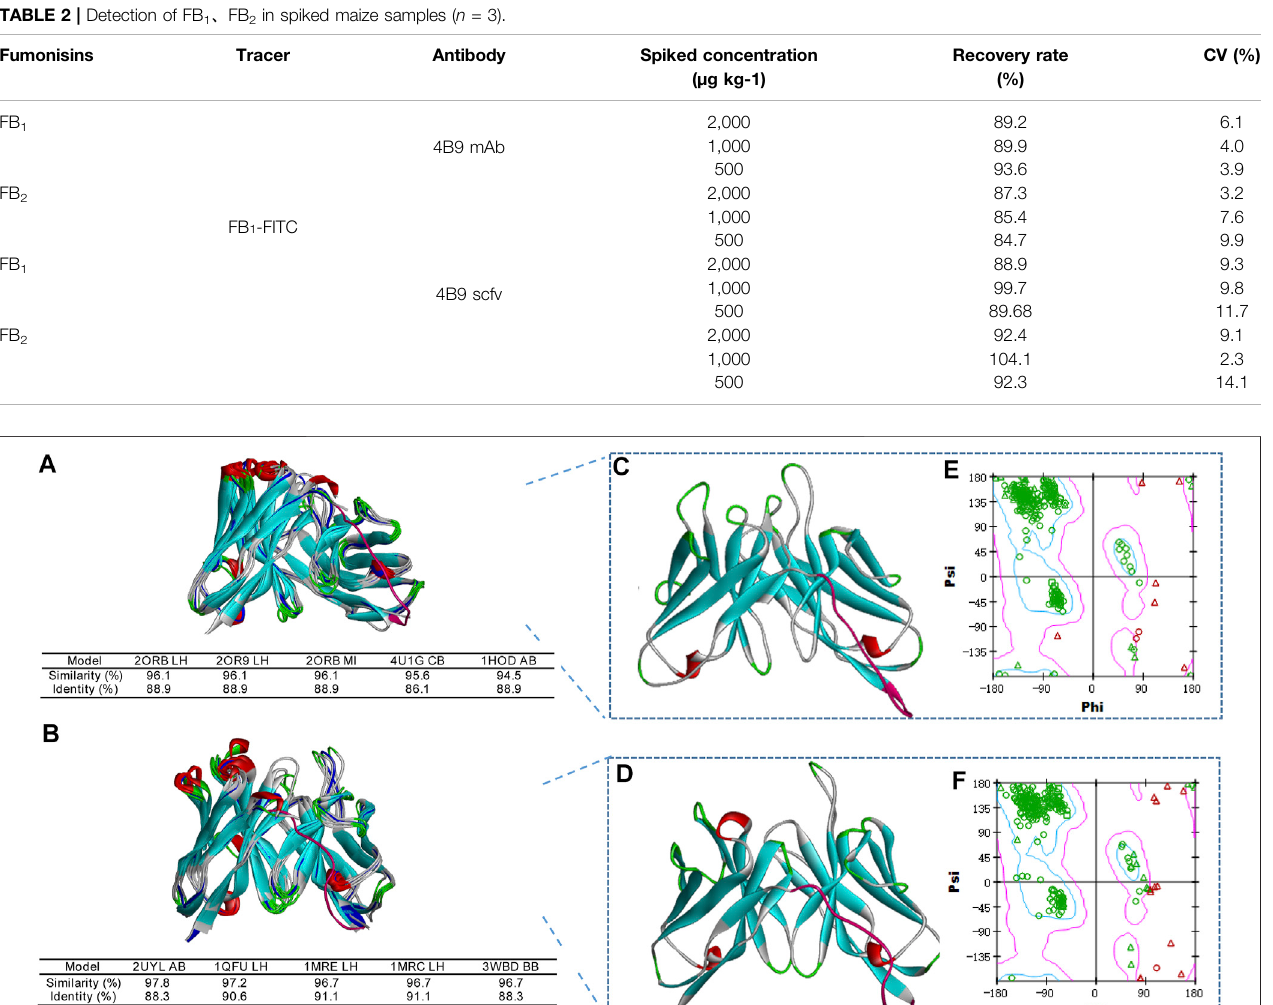
TABLE 2 | Detection of FB 1 、 FB 2 in spiked maize samples ( n = 3). Fumonisins